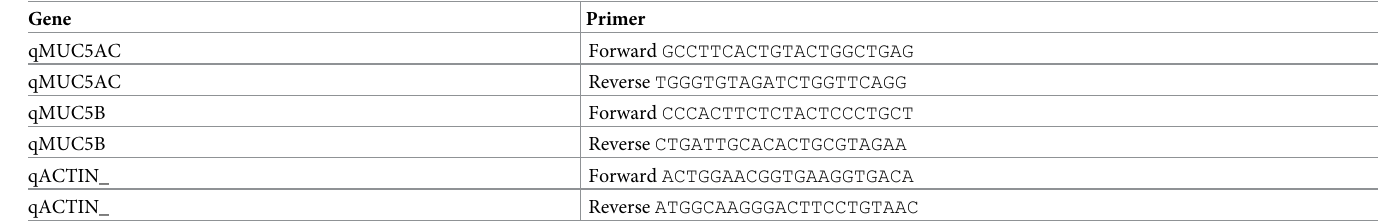
Table 1. Real-time